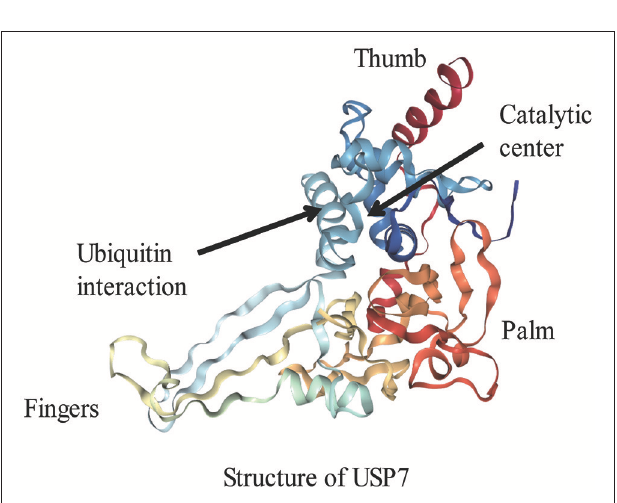
FIGURE 2 | The structure of USP7 (Protein Data Bank (PDB) identifier 1NBF).The fingers, thumb, and palm regions of the USP domain are indicated.